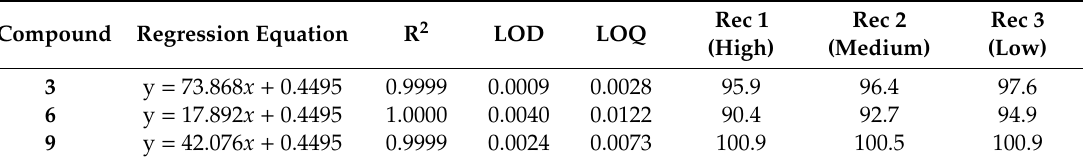
Table 3. Calibration data and percent of recovery rates (Rec, high, medium, and low spike) for three major compounds in I . lactea var. chinensis seeds, including regression equation, correlation coe ffi cient (R 2 ), and limit of detection and quantitation (LOD and LOQ; values in mg / mL). Compound Regression Equation R 2